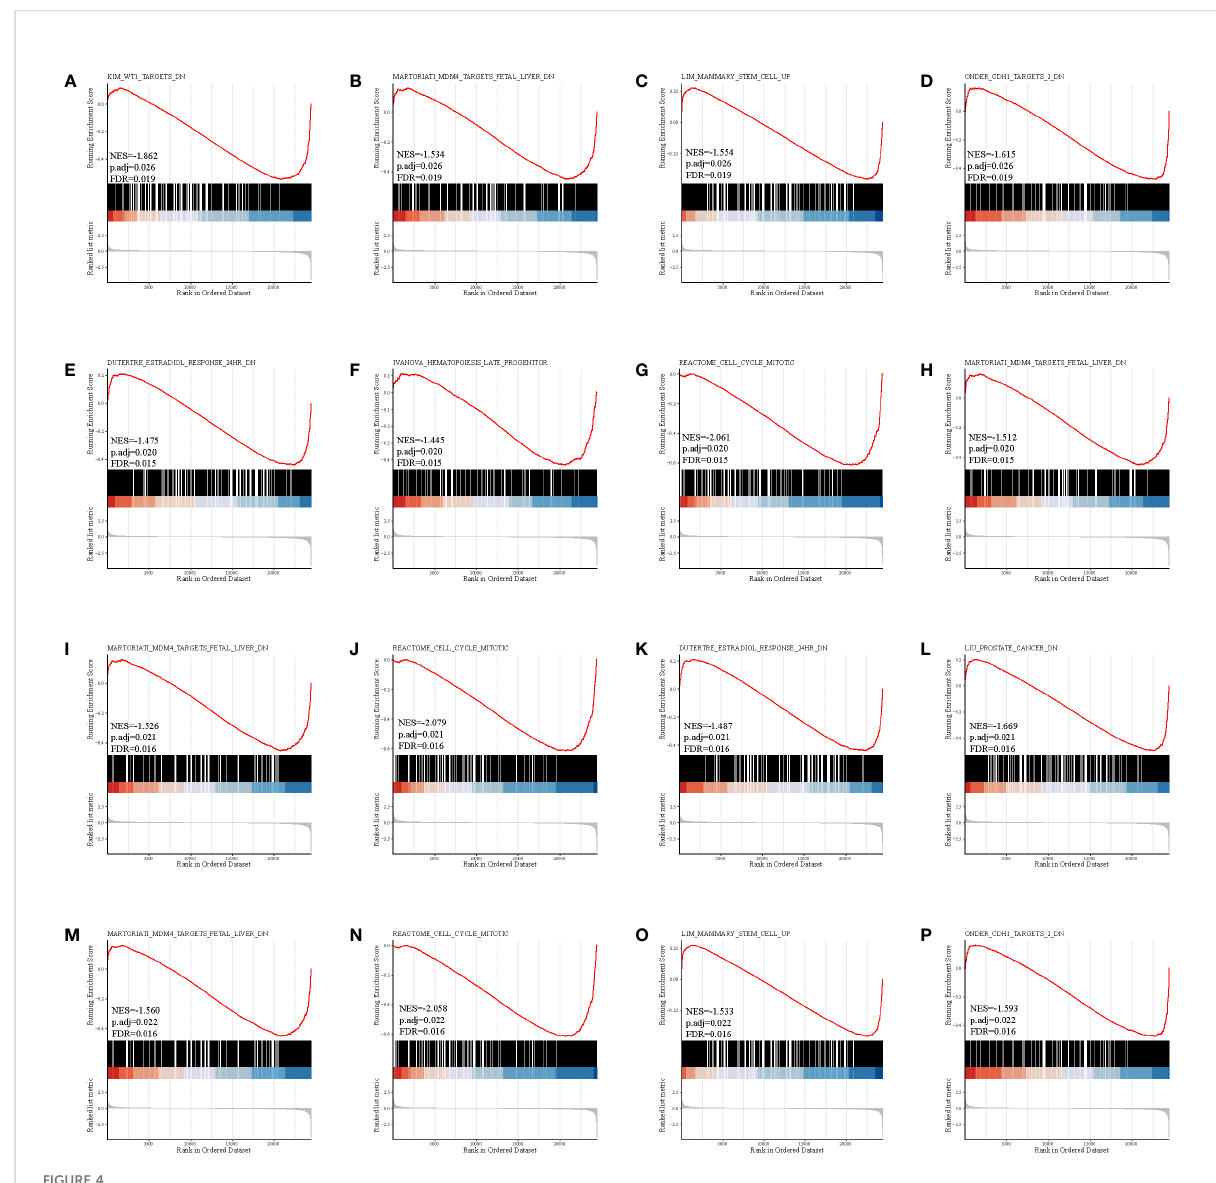
FIGURE 4 Gene set enrichment analysis in GSE7890. (A – D) DKK1, (E – H) JAG1, (I – L) LGR5, and (M – P)